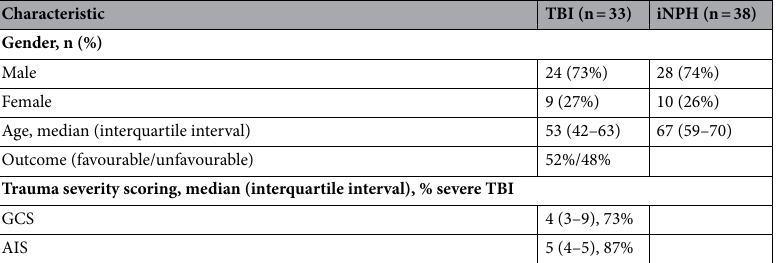
Table 1. Participant demographics. Outcome prediction is dichotomized as unfavourable (GOS = 1–3) and favourable (GOS = 4–5). A total score of 3–8 for GCS or 4–6 for AIS indicates severe TBI. AIS